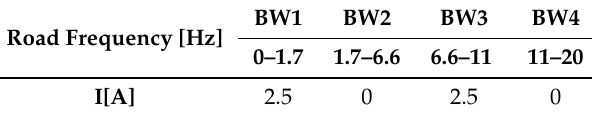
Table 8. FEB Frequency bandwidths for the modified QoV .